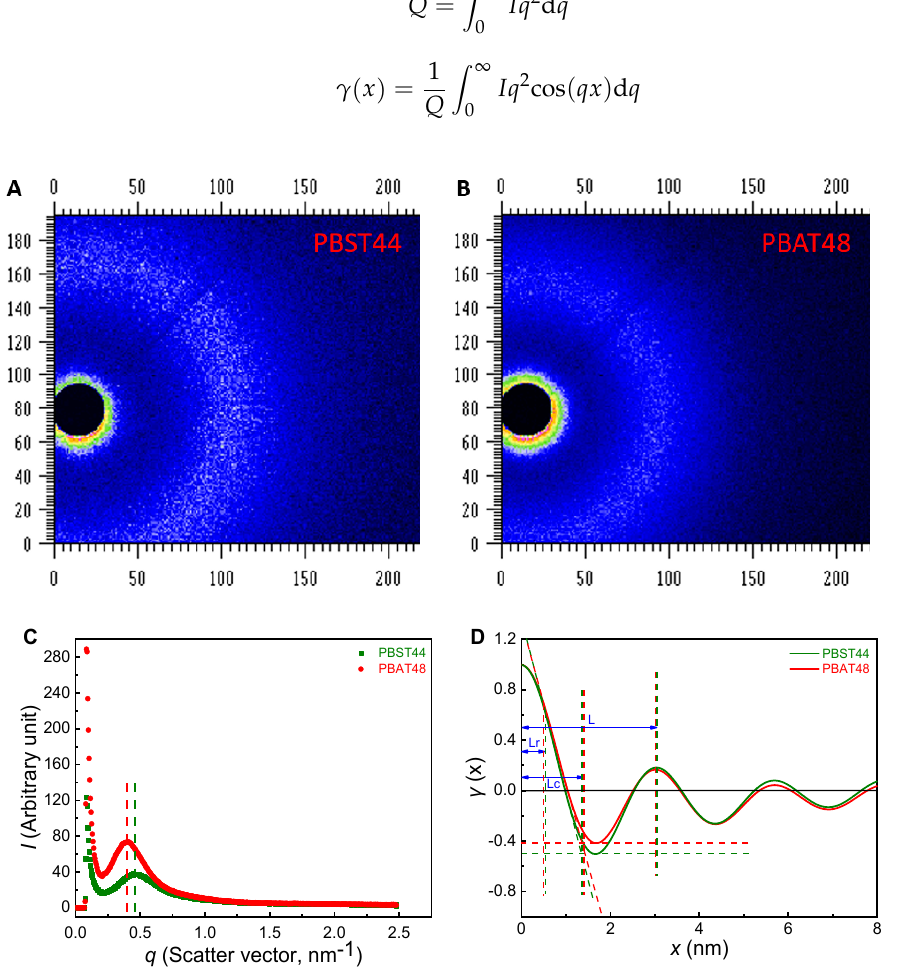
Figure 7. Two-dimensional SAXs patterns of ( A ) PBST44 and ( B ) PBAT48, ( C ) one-dimensional exported data and ( D ) one-dimensional pattern. Table 6. Three-phase layer thickness of PBAT48 and PBST44 calculated from SAXS results.